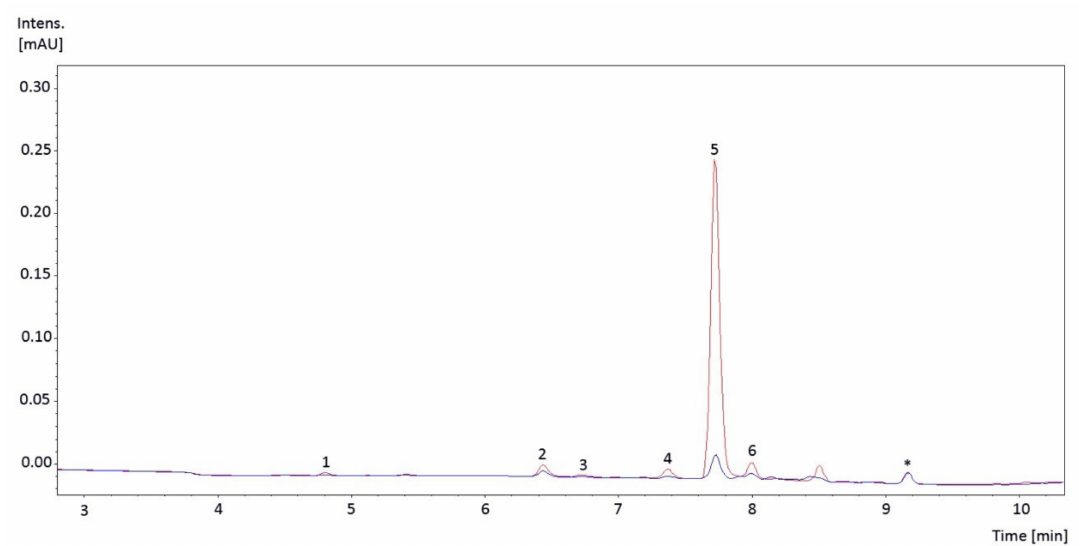
Figure 1. Representative ultra-performance liquid chromatography (UPLC) chromatograms of Marchantia polymorpha subsp. ruderalis Tak-1 samples exposed to the two radiation regimes imposed in the experiment: P (only only photosynthetically active radiation (PAR), blue line) and PAB (PAR + UV-A + UV-B, red line). The identified methanol-soluble UV-absorbing compounds (SUVACs) were: 1, apigenin 7,4 (cid:48) -di- O -glucuronide; 2, luteolin 7,3 (cid:48) -di- O -glucuronide; 3, luteolin 7- O -glucuronide; 4, luteolin 4 (cid:48) - O -glucuronide; 5, apigenin 7- O -glucuronide; and 6 luteolin 3 (cid:48) - O -glucuronide. Internal standard is marked with an asterisk